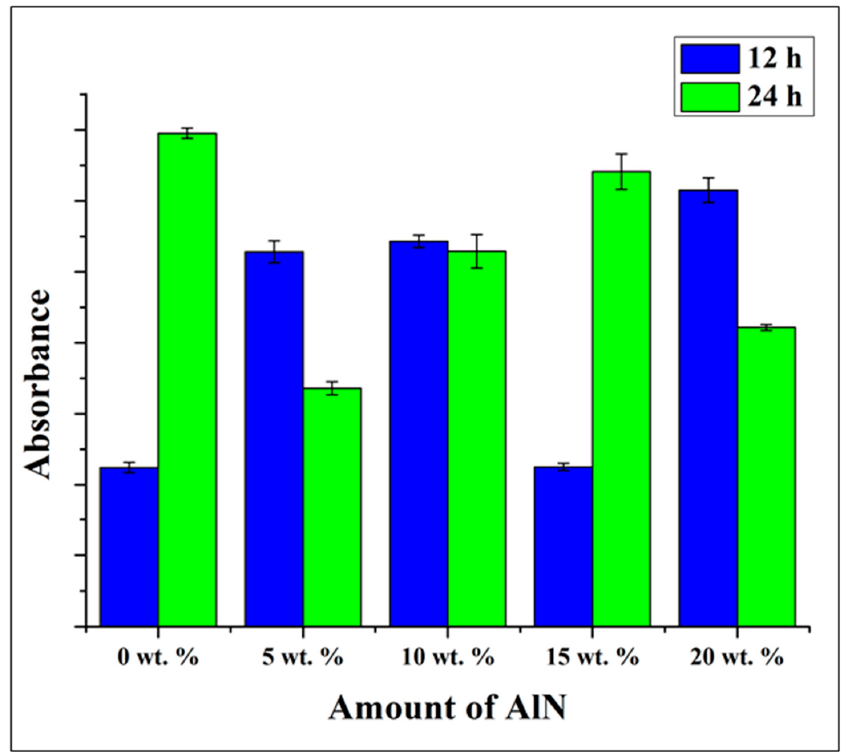
Figure 10. WST adsorption after 12 and 24 h of testing with Escherichia coli on the CA/AlN composites, as a function of the fraction of AlN.